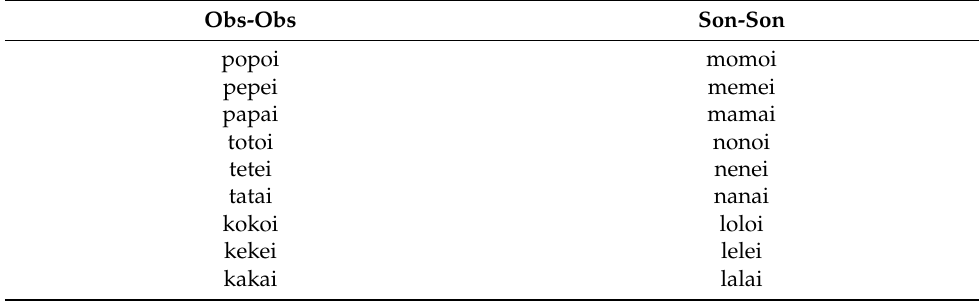
Table 3. The list of stimuli for Experiment 2 (English speakers